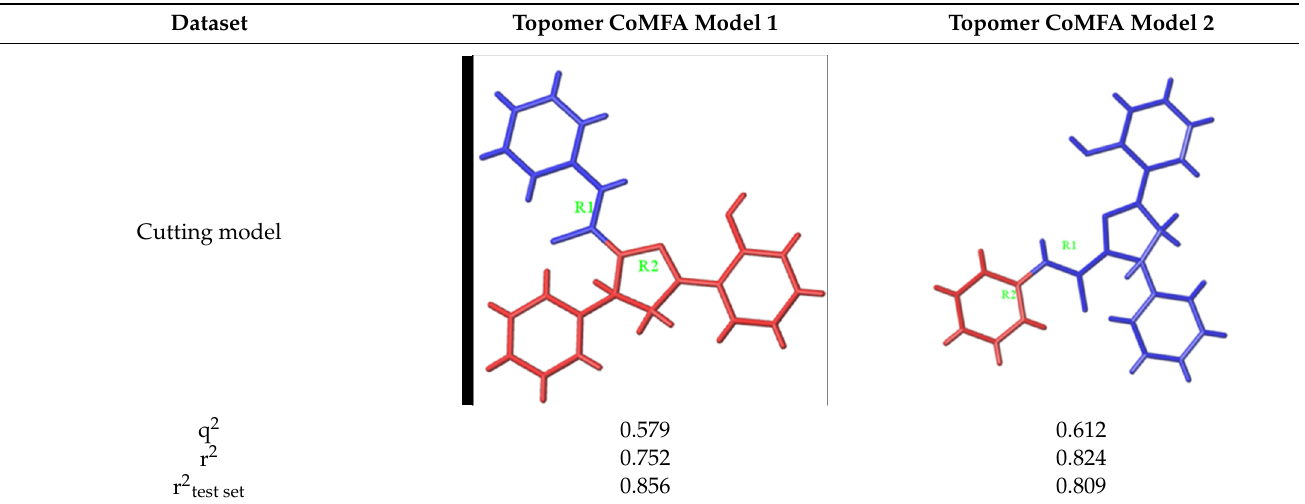
Table 2. Results from the two topomer CoMFA model studies.